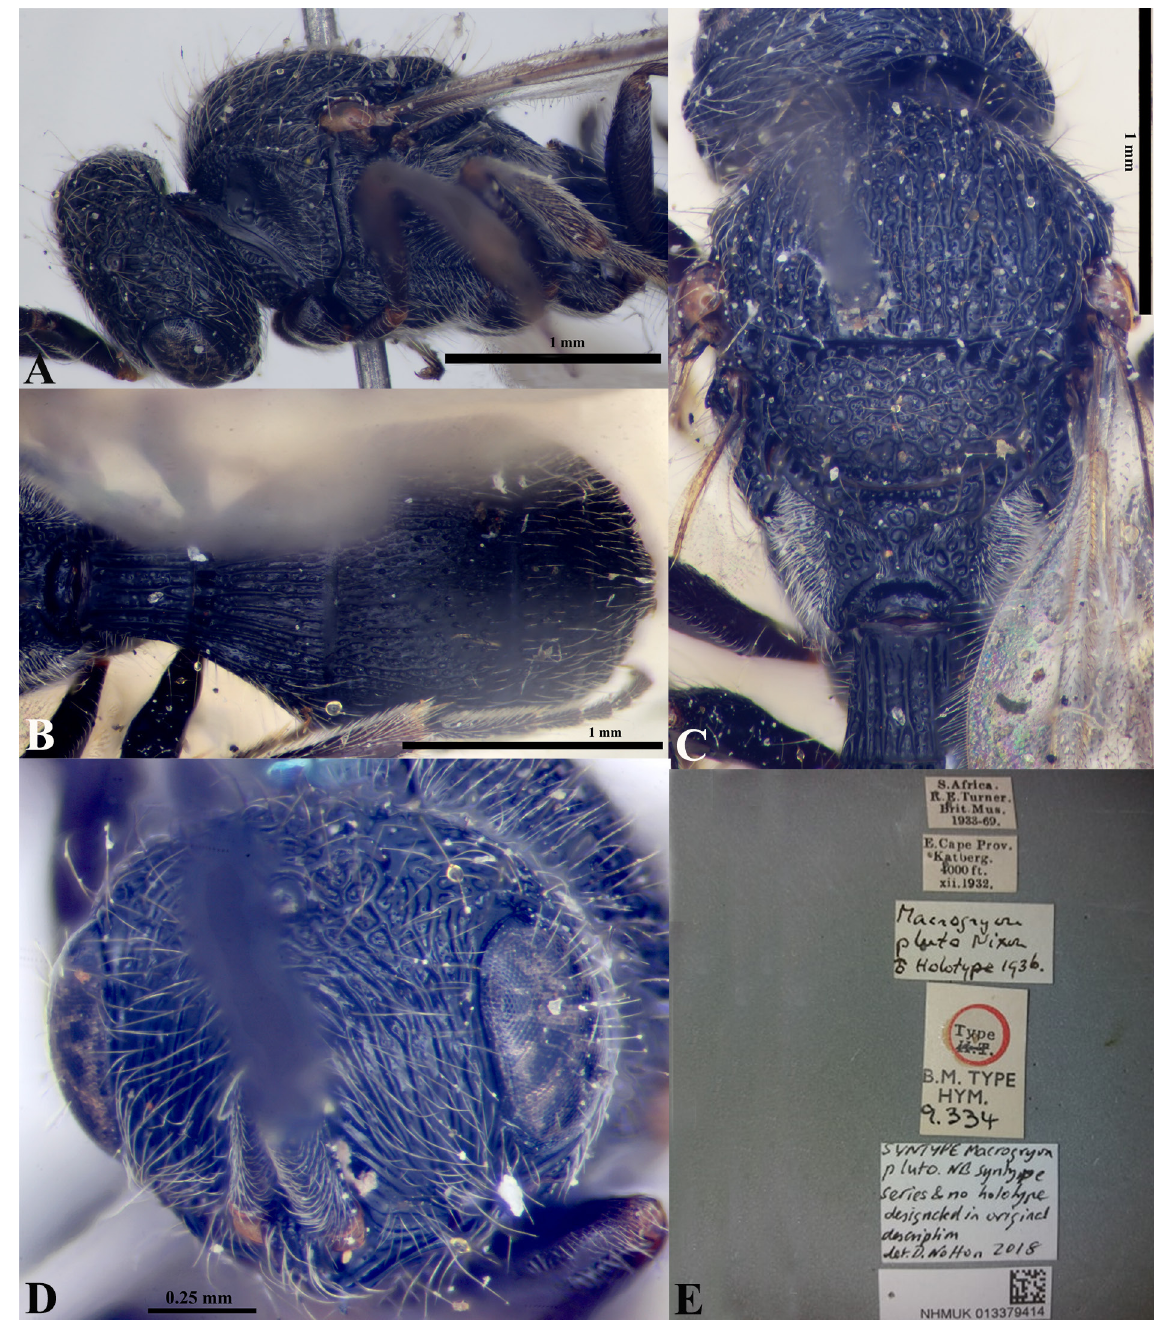
Fig. 16. Odontoscelio pluto (Nixon, 1936). Syntype, ♂ (NHMUK 013379414). A . Head and pleuron. B . Metasoma. C . Head and mesonotum. D . Frons. E . Type label. Photos: D.G. Notton © ,